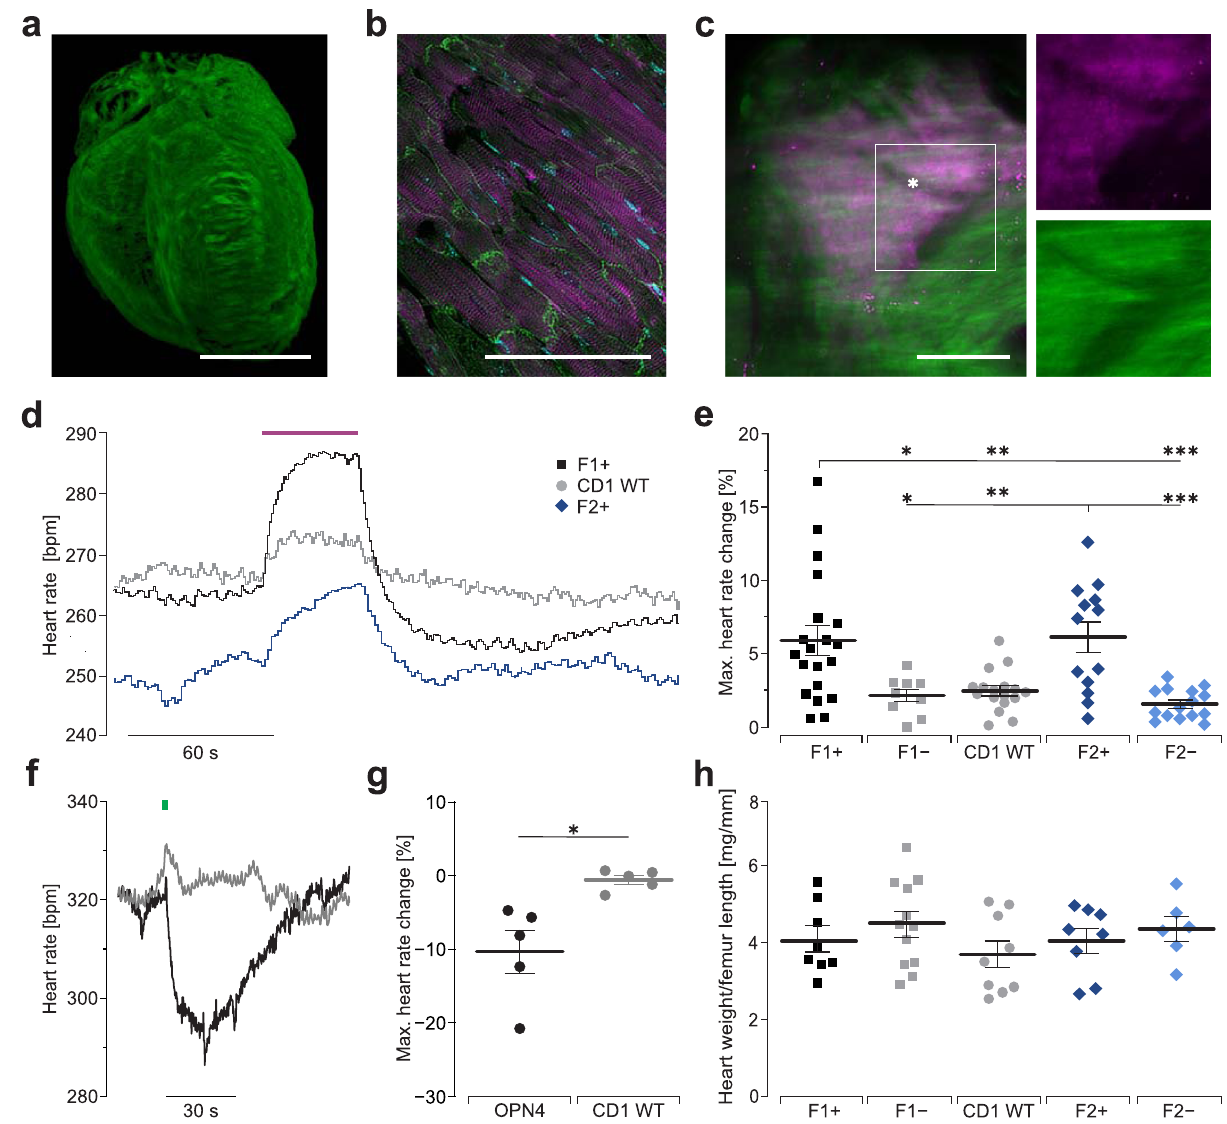
Fig. 6 Modulation of heart rate in hOPN5/eYFP and OPN4/eGFP transgenic hearts. a – c Distribution of hOPN5/eYFP (green) expression in the whole heart ( a ), in a ventricular section with α -actinin (purple) positive cardiomyocytes ( b , DAPI in cyan) and in the sinus node identi fi ed by HCN4 staining ( c , purple). Note the sinus nodal artery as classical landmark ( c , star). Bars = 3 mm a , 100 µ m b , 300 µ m c . d Representative heart rate traces from hearts of hOPN5/eYFP founder line #1 and #2 with hOPN5 expression (F1 + , F2 + ), and wild-type control mice (CD1 WT) upon illumination of the dorsal right atrium with UV light (385 nm, 1 mW/mm 2 , 10 s). e Statistical analysis of the light induced maximum heart rate increase in hOPN5/eYFP hearts (F1 + , F2 + ) and wild-type hearts (CD1 WT) as well as hOPN5 negative littermates (F1 − , F2 − ) from both founder lines. Each dot represents the average from one heart and statistical analysis was performed with a one-way non-parametric ANOVA test with Tukey ’ s multiple comparison post-test (p(F1 + vs. F2 + ): 0.99; p(F1 − vs. CD1 WT): 0.99; p(F1 − vs. F2 − ): 0.99; p(CD1 WT vsF2 − ): 0.91). f Representative time course of changes in beating rate in an OPN4/eGFP (black) and a CD1 WT heart (gray) upon blue light (460 nm, 1 s, 1.4 mW/mm 2 ) application to the same region as in d . g Statistical analysis ( n = 5) of maximal change in heart rate using two-sided unpaired Student ’ s t test ( p = 0.01). h Analysis of the heart weight to femur length in 2-months-old hOPN5/eYFP mice with a ordinary one-way ANOVA test with Tukey ’ s multiple comparison post-test (p(F1 + vs. F1 − ): 0.88; p(F1 + vs. CD1 WT): 0.93; p(F1 + vs. F2 + ): 0.99); p(F1 + vs. F2 − ): 0.98; p(F1 − vs. CD1 WT): 0.37; p(F1 − vs. F2 + ):0.86; p(F1 − vs. F2 − ): 0.99; p(CD1 WT vs. F2 + ): 0.94; p(CD1 WT vs. F2 − ): 0.71; p(F2 + vs. F2 − ): 0.97). Each dot represents the result from one heart. Data are presented as mean values ±SEM. * p < 0.05, ** p < 0.01, *** p <